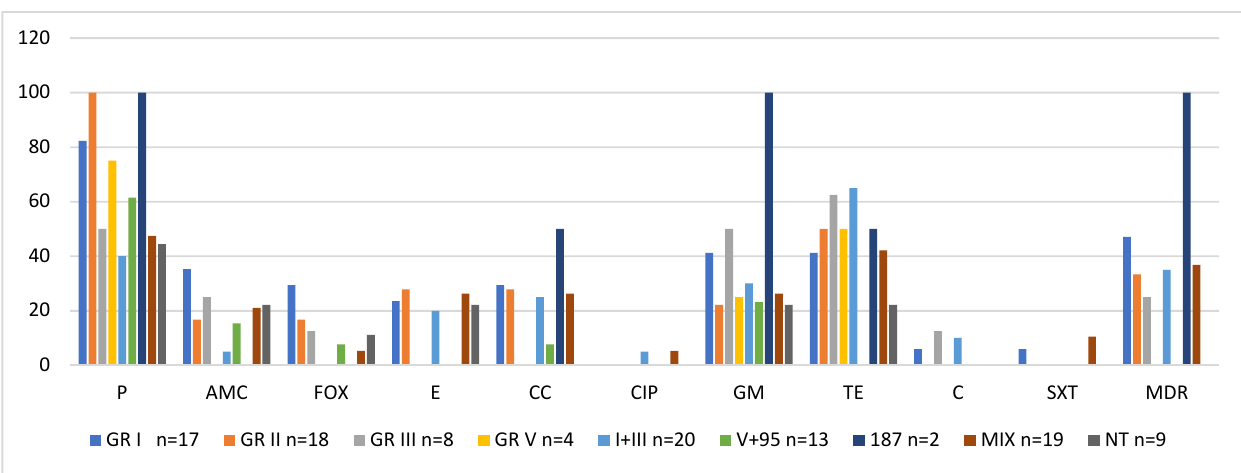
Figure 2. Sensitivity of 110 oral S. aureus strains to specific lytic phages from international set.